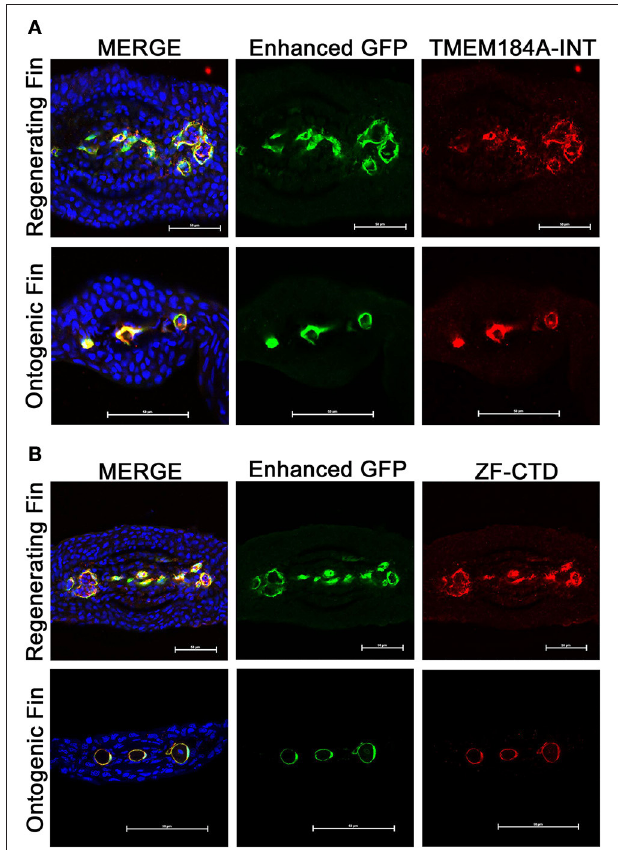
FIGURE 1 | Ontogenic and regenerating zebrafish fins express Tmem184a in the vasculature. Representative confocal microscopy images of cryogenic transverse sections of regenerating and ontogenic Tg(Fli1:EGFP) fins. All sections were stained with a GFP antibody to enhance EC fluorescence/visualization along with DAPI to easily identify fin rays. (A) Sections were stained for Tmem184a using a commercial antibody. (B) Sections were stained for Tmem184a using a zebrafish-specific antibody (ZF-CTD). Each image shows one individual fin ray. The arrowhead points to a mature artery, and the arrows mark mature veins. Scale bars = 50 µ m. DAPI staining is blue, EC staining is green, and Tmem184a staining is red for all images. Sections from more than 10 individual fish were immunostained and analyzed for each combination of antibodies.